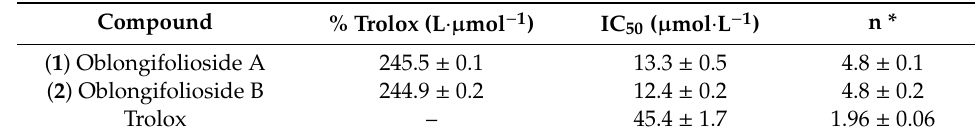
Table 2. Antiradical activity of compounds 1 – 2